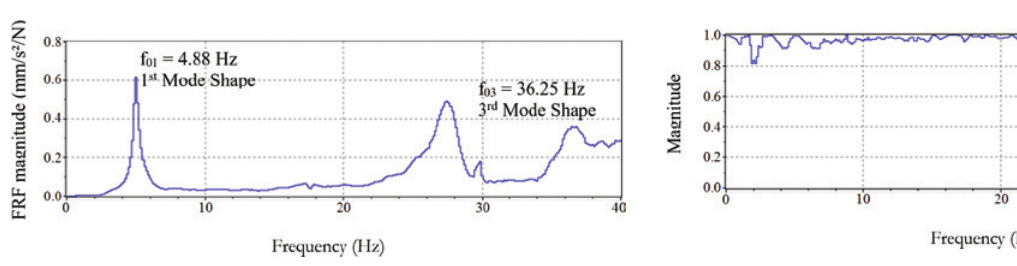
(c) Point 2 (1/2 of the span): FRF